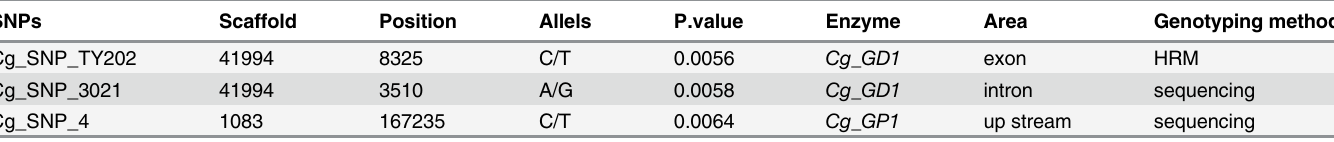
Area was the relative location of the SNP to the gene. Cg_GD1 , glycogen debranching enzyme encoding gene 1. Cg_GP1 , glycogen phosphorylase encoding gene